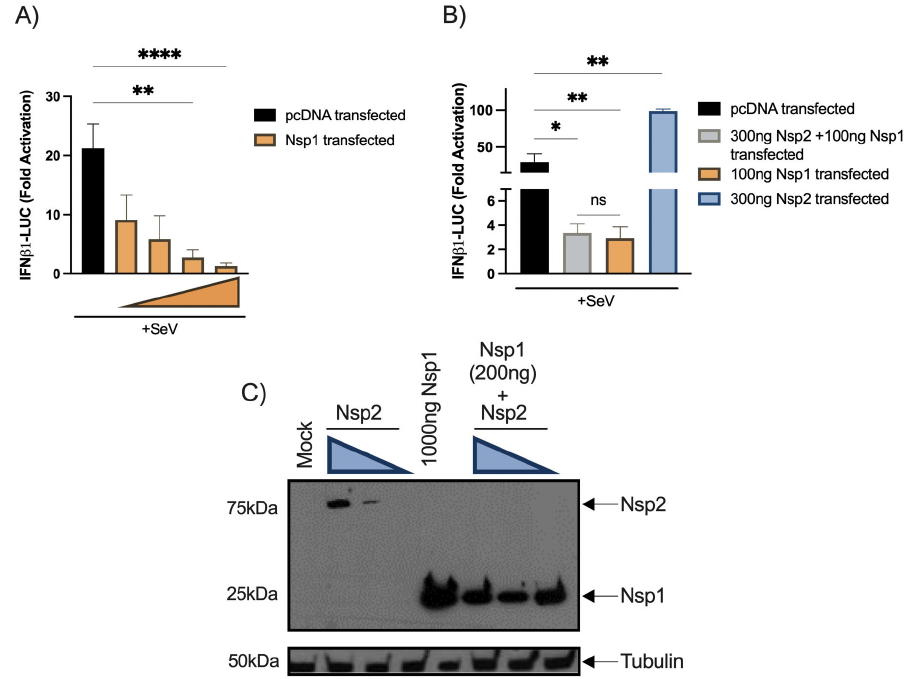
Figure 5. Effect of SARS-CoV-2-Nsp1 and Nsp1-Nsp2 cotransfection on SeV-induced IFN β 1 promoter activation. HEK293T cells were seeded, transfected, and simulated according to the procedure described above and the luciferase activity was measured then standardized as described for other reporter assays. Doses of 300 ng, 100 ng, 30 ng, and 3 ng per well of Nsp1 vectors for Nsp1 alone experimentation ( A ). HEK293T cells were seeded, transfected, and simulated according to the procedure described above and the luciferase activity was measured then standardized as described for other reporter assays. Doses of 300 ng of Nsp2 aand 100 ng of Nsp1 per well were used ( B ). All experiments were performed twice in triplicate and the compilation of the data is shown. Results are expressed as fold activation relative to the pcDNA mock-infected control (mean ± SD, n = 6 replicates/condition). The Nsp1-Nsp2 cotransfection and Nsp1 transfection conditions were compared to the mock-transfected control using nonparametric one-way ANOVA with Dunn’s correction and Nsp2 conditions were compared using nonparametric one-way ANOVA. The Nsp1-Nsp2 cotransfection and Nsp1 transfection conditions were compared using nonparametric t -test. * p < 0.05, ** p < 0.01, **** p < 0.0001, ns: not significant. Protein expression of Nsp1 and Nsp2 in individual transfection and cotransfection ( C ). HEK293T were seeded in 6-well plate. Twenty-four hours after, cells were transfected with control vector or Nsp1 expression vector or Nsp2 expression vector. Doses of 800 ng, 500 ng, and 100 ng of Nsp2 vector were used. Forty-eight hours post-transfection, cells were lysed in SDS PAGE 2X buffer and detected by Western Blot with an anti-FLAG (viral protein) and rabbit anti-tubulin β (loading control) on radiological films. The Western Blot was performed two times and one representative experiment is